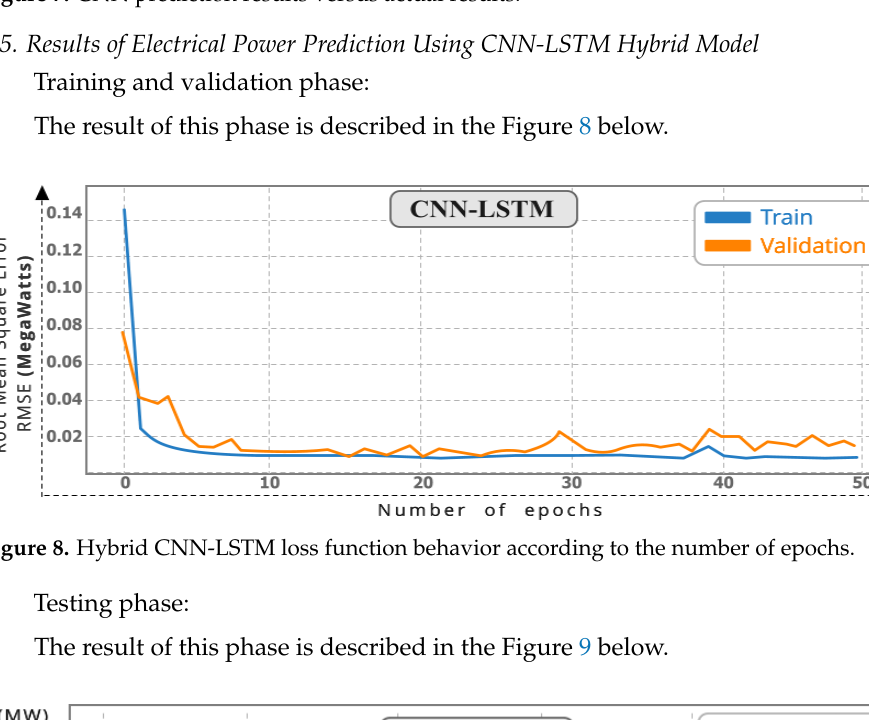
Figure 7. CNN prediction results versus actual results.